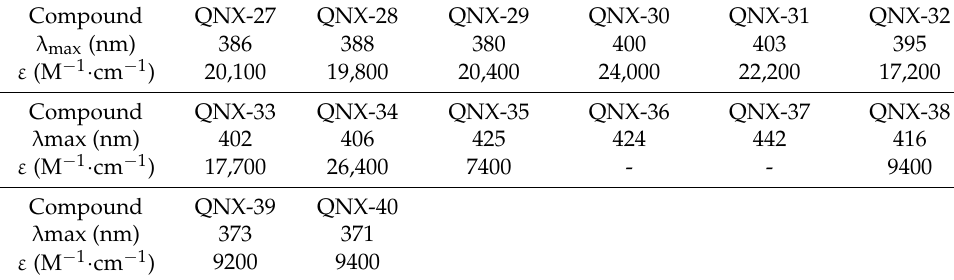
Table 11. Optical properties of the different dyes in 1-methyl-2